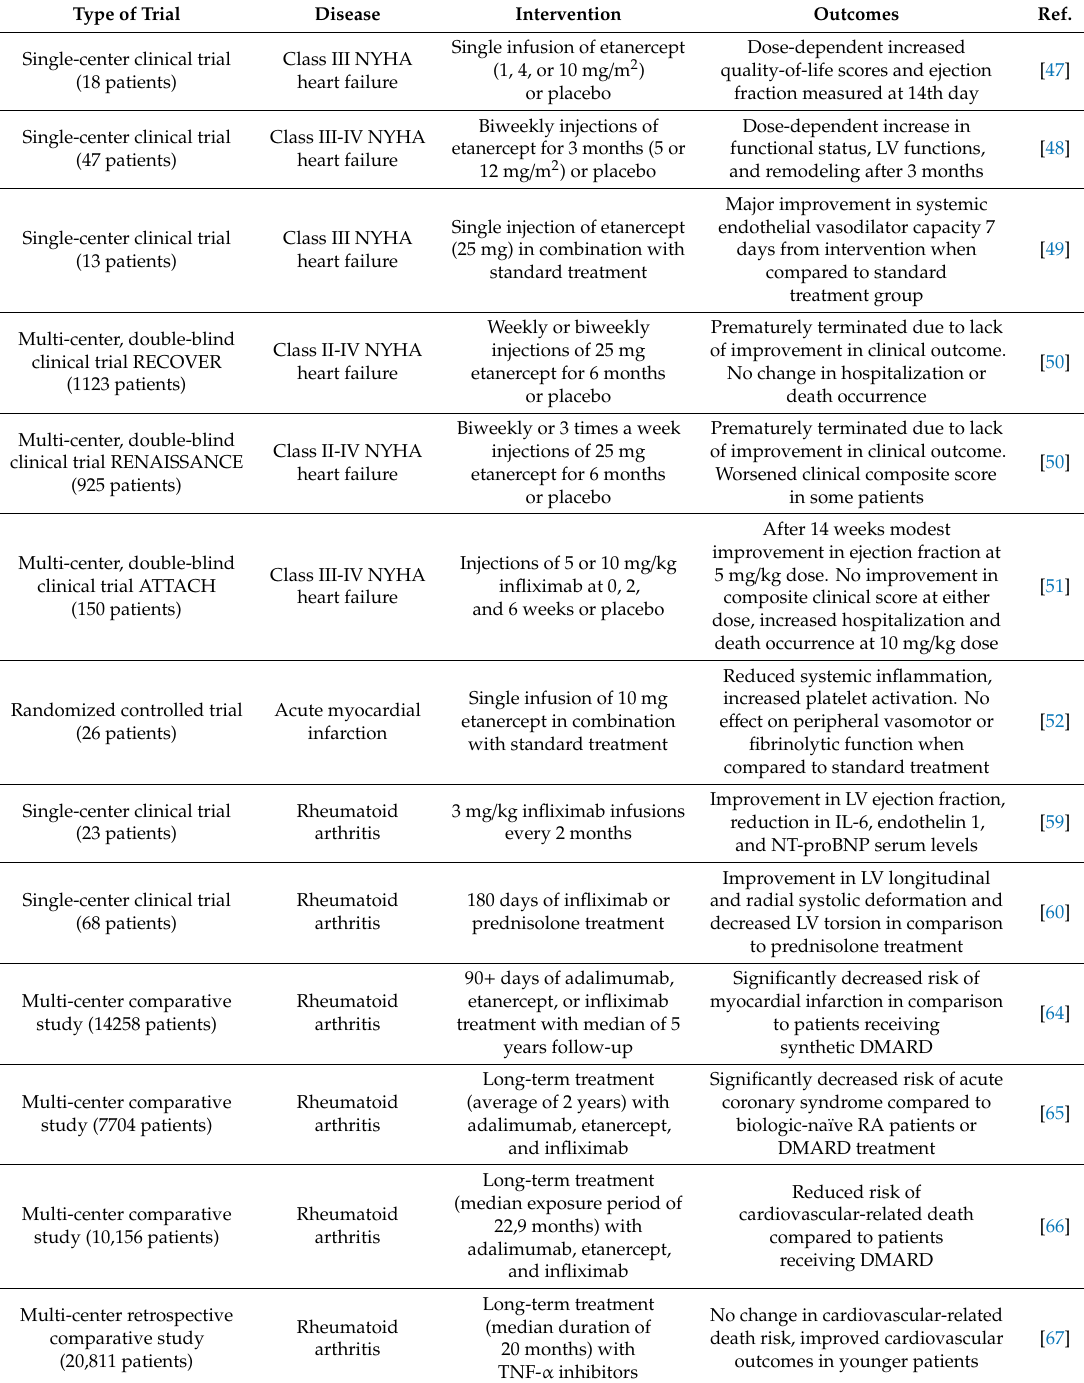
Table 1. E ff ects of anti-TNF- α treatments on cardiovascular outcomes in heart failure and in systemic inflammatory disease